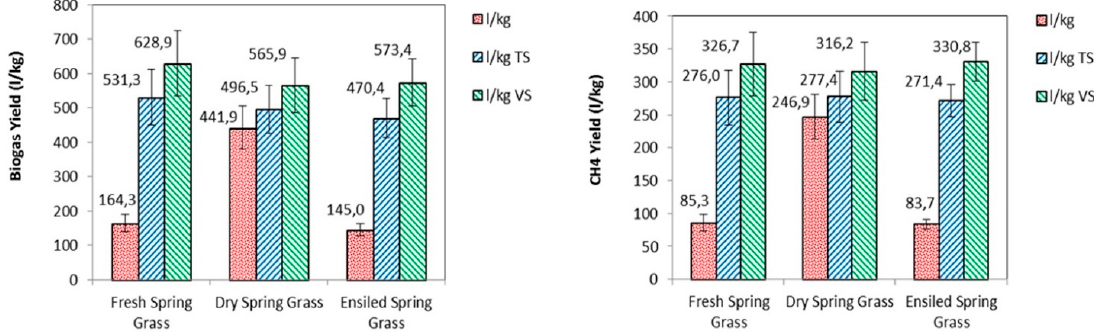
Figure 5. Biogas yield and methane yield of fresh, dry, and ensiled spring grass compared to wet mass, total solids and volatile solids.